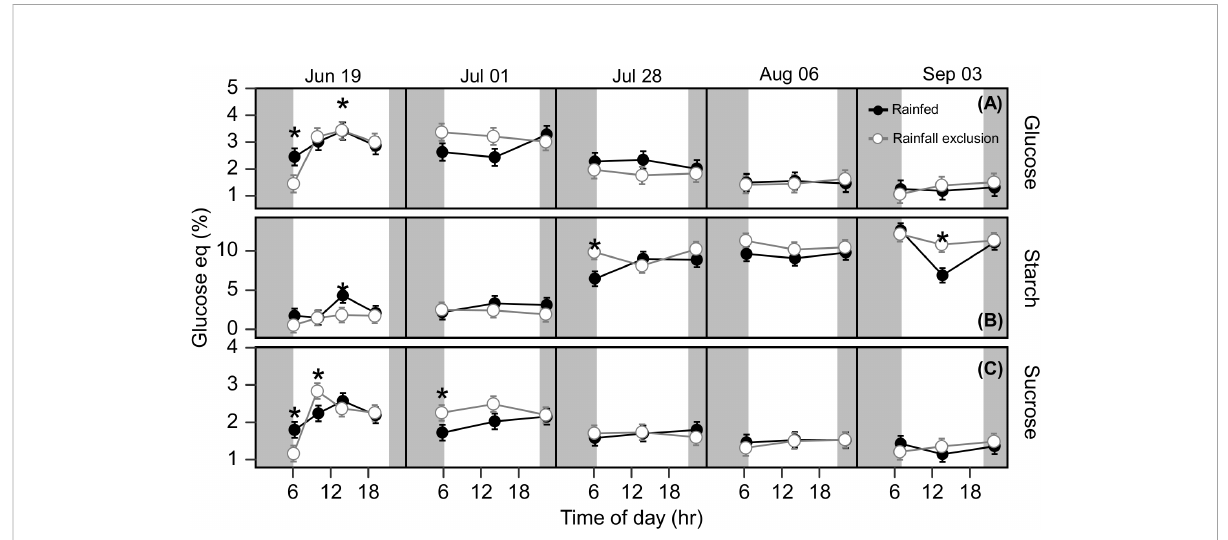
FIGURE 5 Rhizome free glucose (A) , starch (B) and sucrose (C) at each timepoint during the day, over the course of the growing season, for plants grown inside (white fi ll, grey line) and outside (black fi ll, black line) rainfall exclusion shelters. Asterisks indicate a signi fi cant difference between treatments (P< 0.05). Data are mean ± S.E. (n = 4).